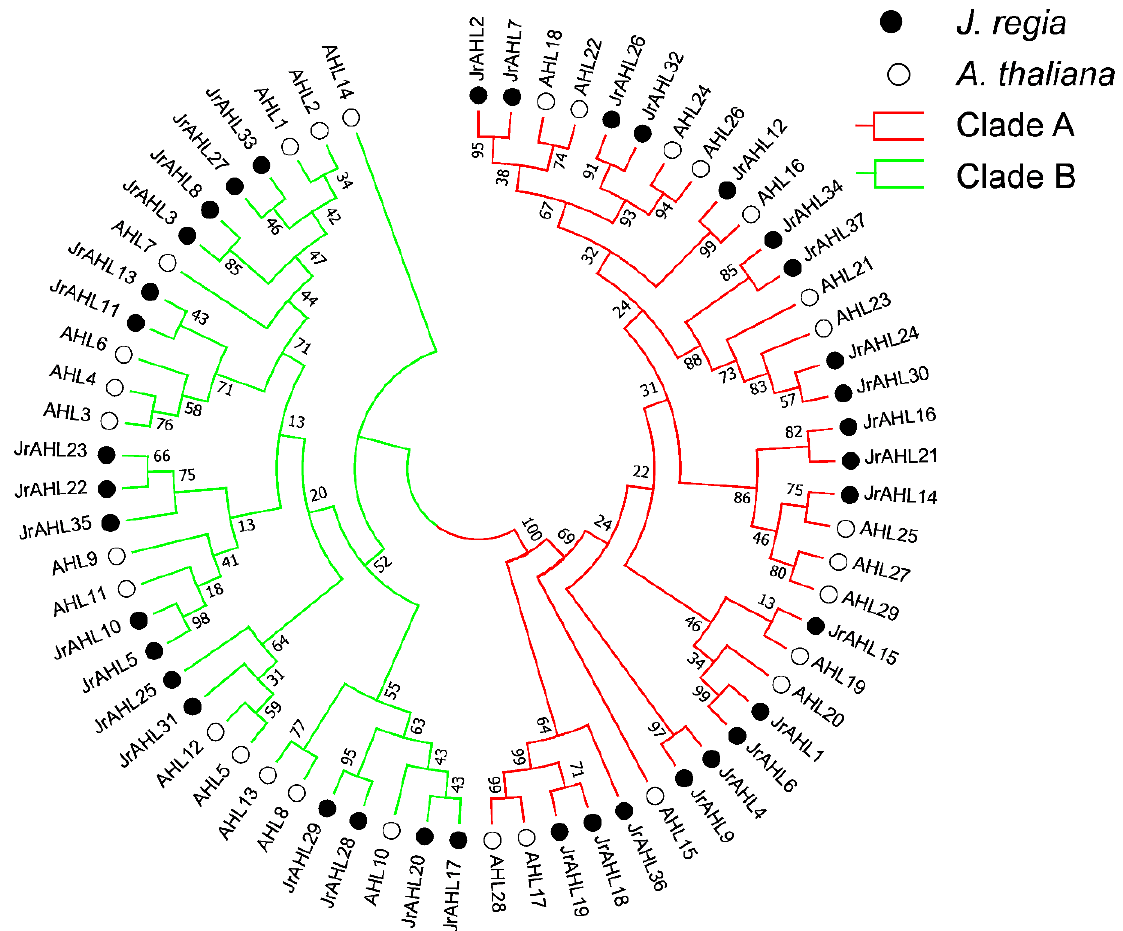
Figure 1. Neighbor-joining tree representing phylogenetic relationships among AHL genes from walnut and Arabidopsis. The evolutionary history was inferred using the Neighbor-Joining matrix-based method and are in the units of the number of amino acid substitutions per site. The rate variation among sites was modeled with a gamma distribution. Evolutionary analyses were conducted in